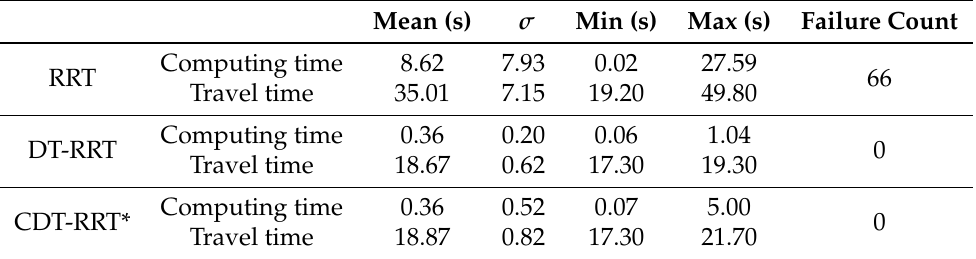
Table 3. Summary of Planning Results from simulation